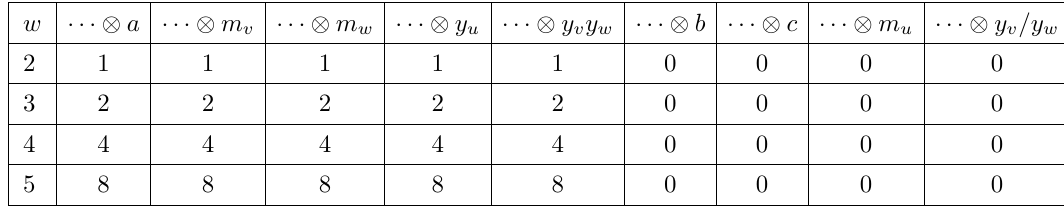
Table 23 . The number of terms in table 22 whose middle w (cid:0) 2 entries do not vanish in the limit